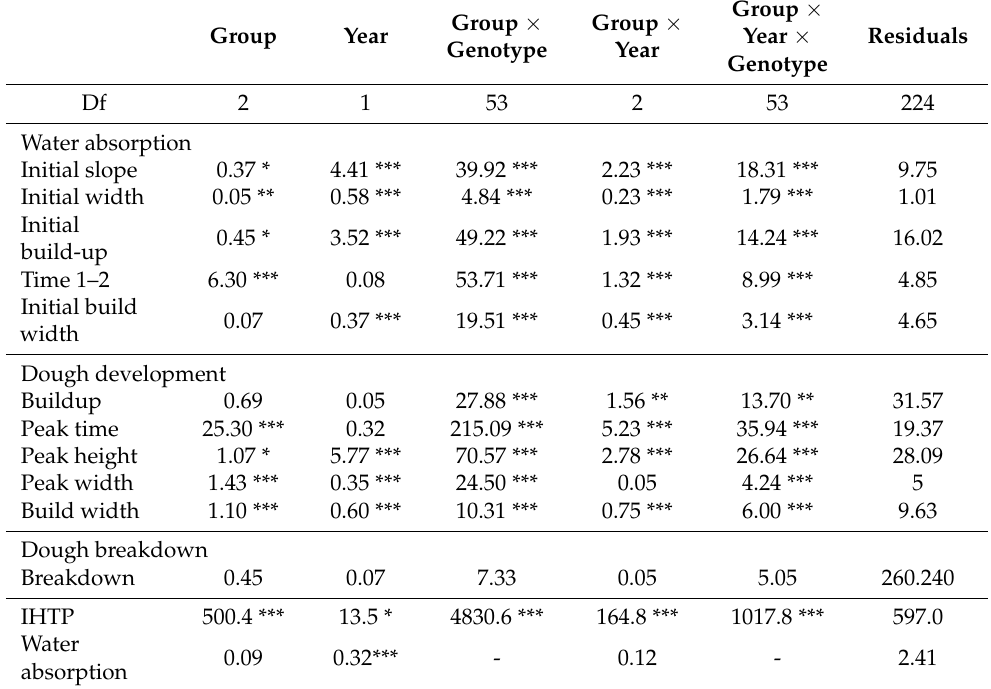
Table 1. Analysis of variance (ANOVA) showing the effect of group, year, and wheat genotype and their interaction on the mixing characteristics of the 56 spring wheat genotypes grown in cool (2017) and heat–drought (2018) years. Data are presented as mean values calculated from three replicates for each parameter.